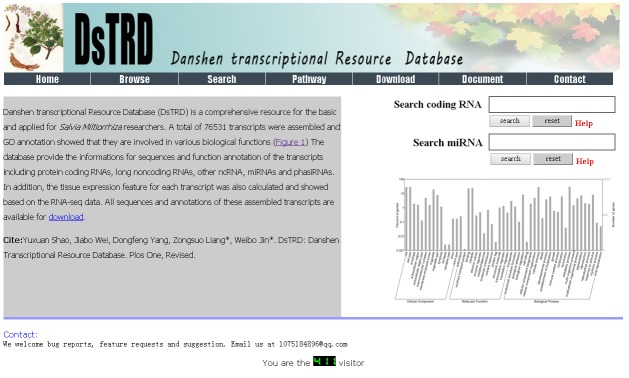
DsTRD home page.